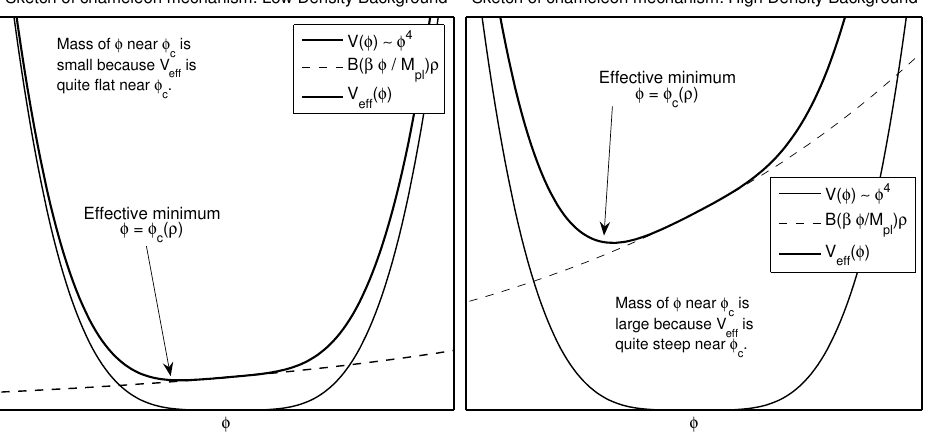
Figure 2. Chameleon mechanism for a potential with a minimum at φ = 0 : V ∼ φ 4 . The left plot corresponds to small matter density and the plot to the right corresponds to large matter density (see [30]). Once again, the mass of the chameleon is growing with the matter density. These plots can be found in [30]. (Reprinted figures with permission from David F. Mota and Douglas J.